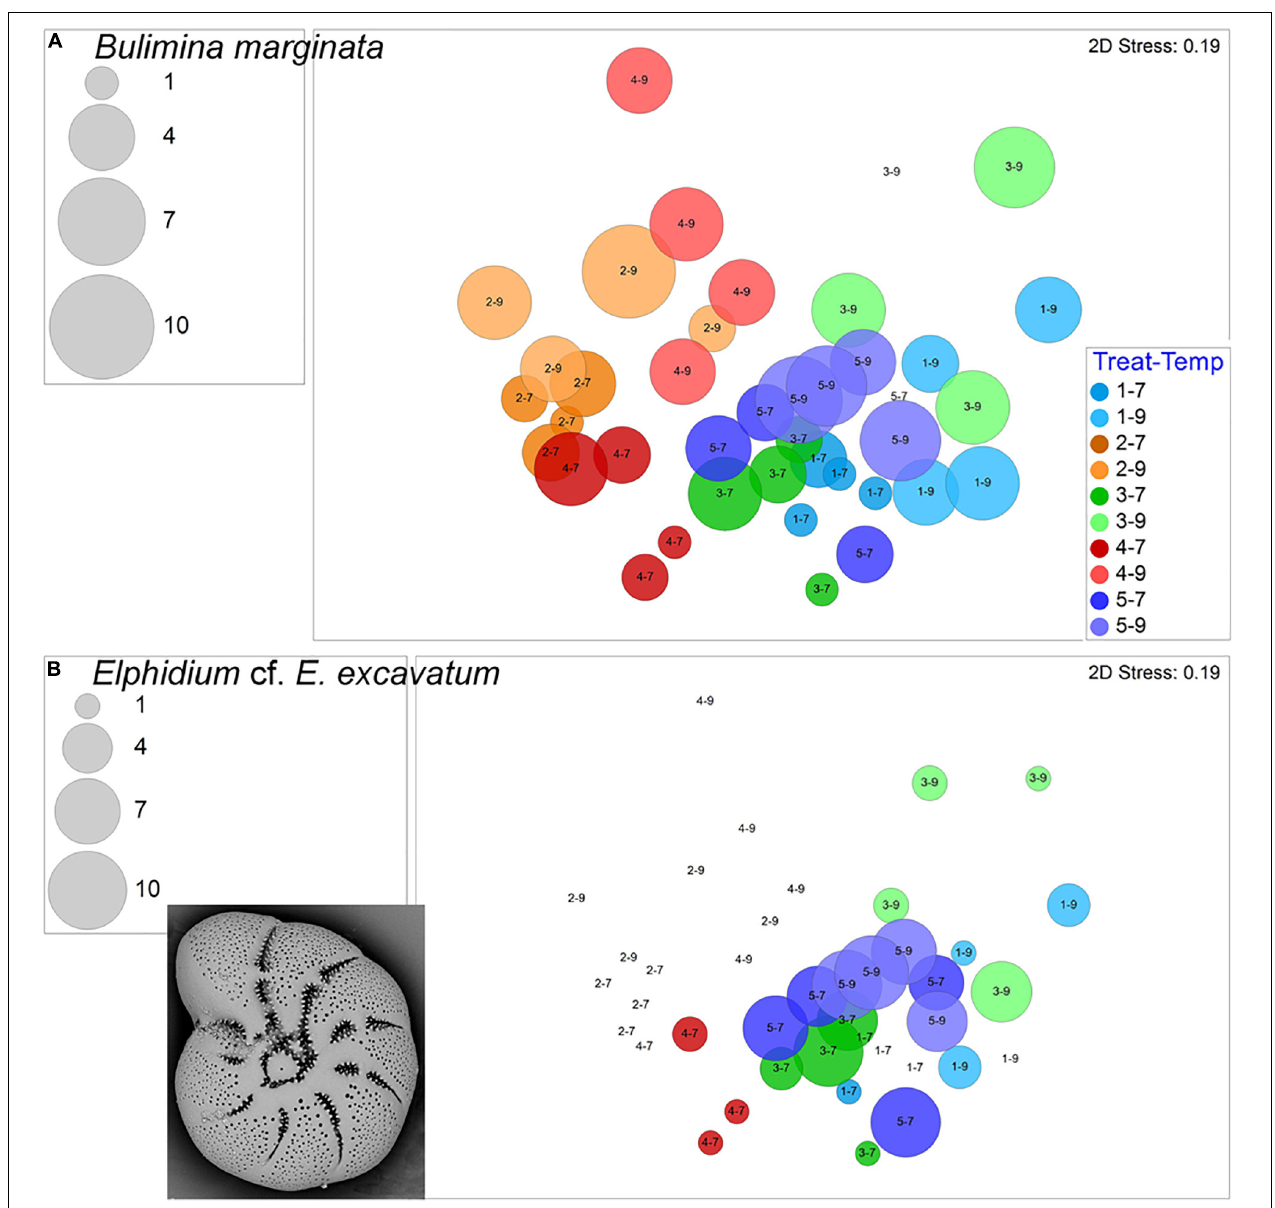
FIGURE 9 | Bubble plots projecting abundances in containers (7 ◦ C Total/9 ◦ C Live) by morphospecies on 2-D nMDS plots. Bubbles are color coded to treatment; lighter shade represents warmer assemblages. Circle diameter is keyed to abundance. (A) Bulimina marginata ; (B) Elphidium cf. E. excavatum , inset is SEM micrograph. Treatment 1 (blue) is Present Day; Treatment 2 (orange) is Hypoxia; Treatment 3 (green) is OA; Treatment 4 (red) is OA + Hypoxia; Treatment 5 (purple) is